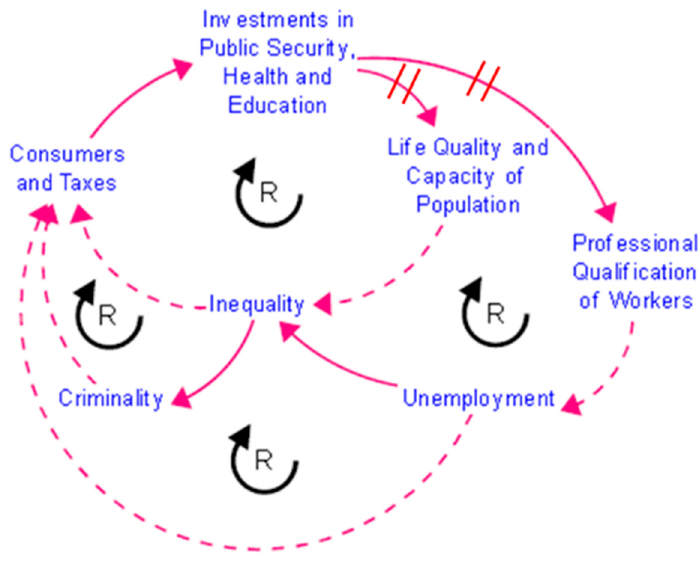
Figure 5. Second partial scheme of the CLD of GQ3.